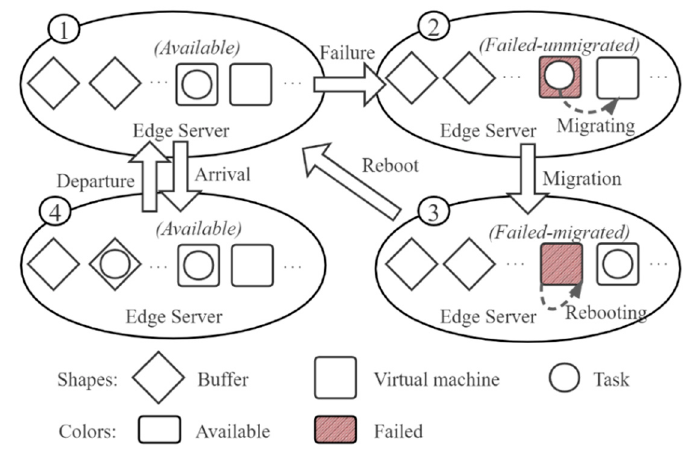
Figure 3. State transitions of virtual machines (VM) in an edge server.